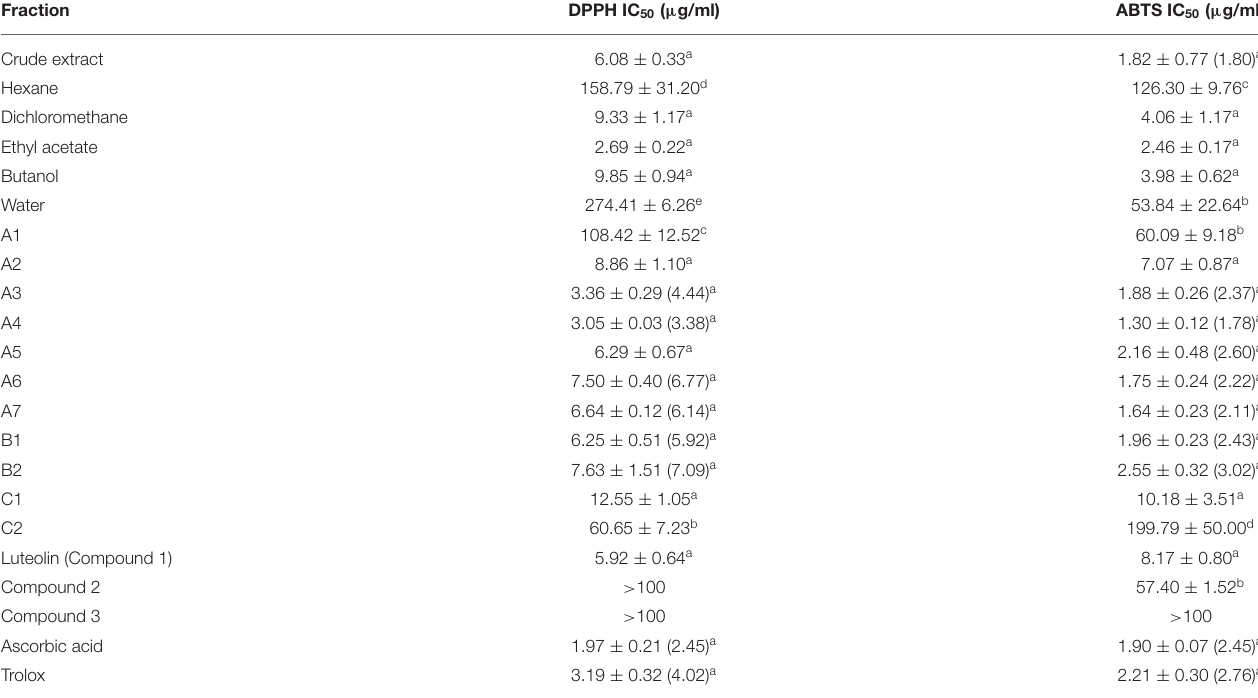
TABLE 3 | Antioxidant activity of S. singueana fractions.